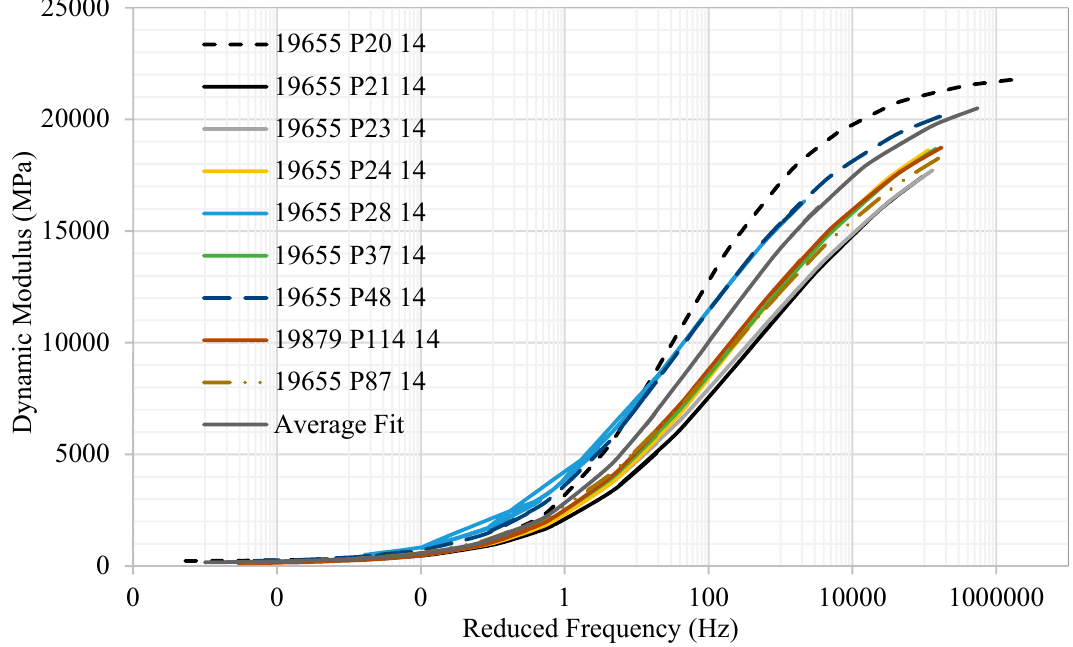
Figure 3. Dynamic modulus of the SX(100) PG 64-28 mix.